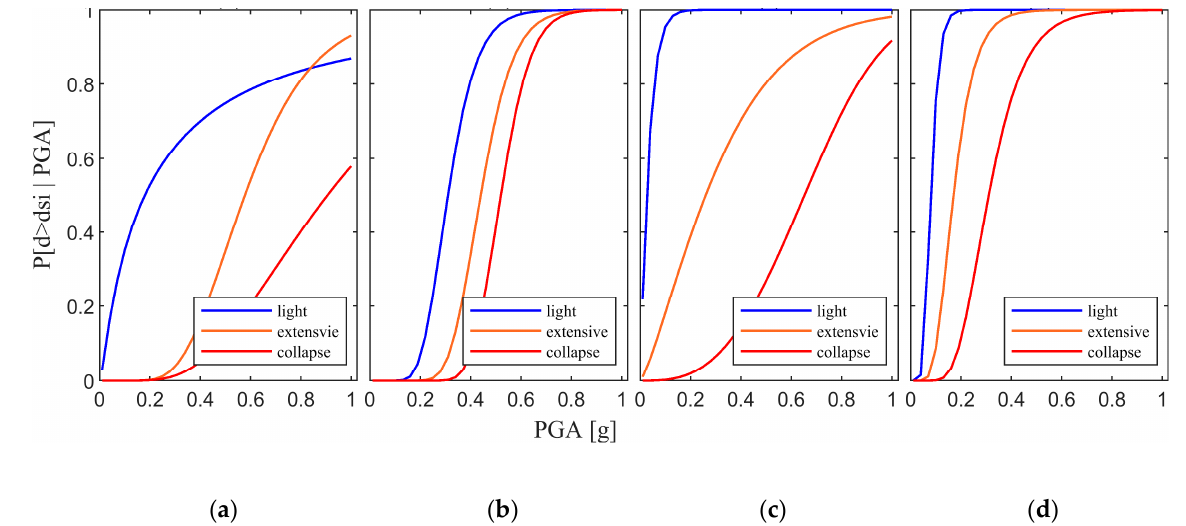
Figure 10. Fragility curves: observational ( a ) Del Gaudio et al. [30]; ( b ) De Luca et al. [31]; ( c ) Rossetto and Elnashai [5]; and analytical ( d ) Ahmad et al. [22].